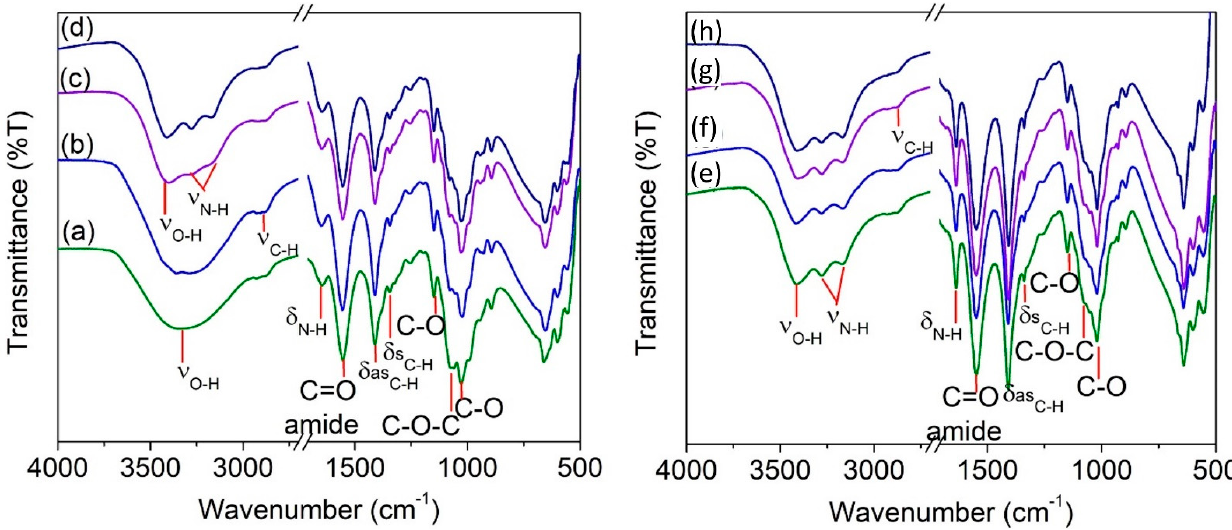
Figure 2. FTIR spectra of ( a ) pristine chitosan, ( b ) NCS1, ( c ) NCS2, ( d ) NCS3, ( e ) NCS4, ( f ) NCS5, ( g ) NCS6 and ( h ) NCS7 samples where ν = stretching, δ = bending, δ s = symmetrical bending and δ as = asymmetrical bending modes.